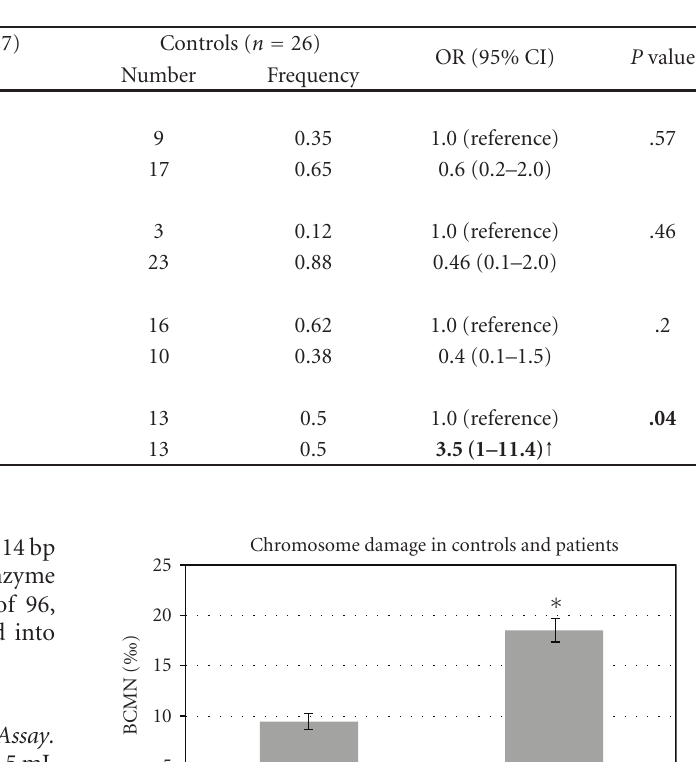
Figure 1. BC patients exhibited higher levels of chromosome damage than controls according to BCMN ( P < .